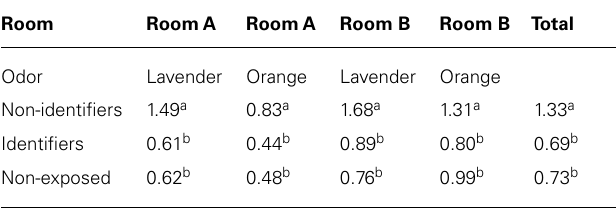
Table 1 | Ratings of fit of the odors to the rooms by non-identifiers, identifiers, and non-exposed subjects (Degel etal., 2001).